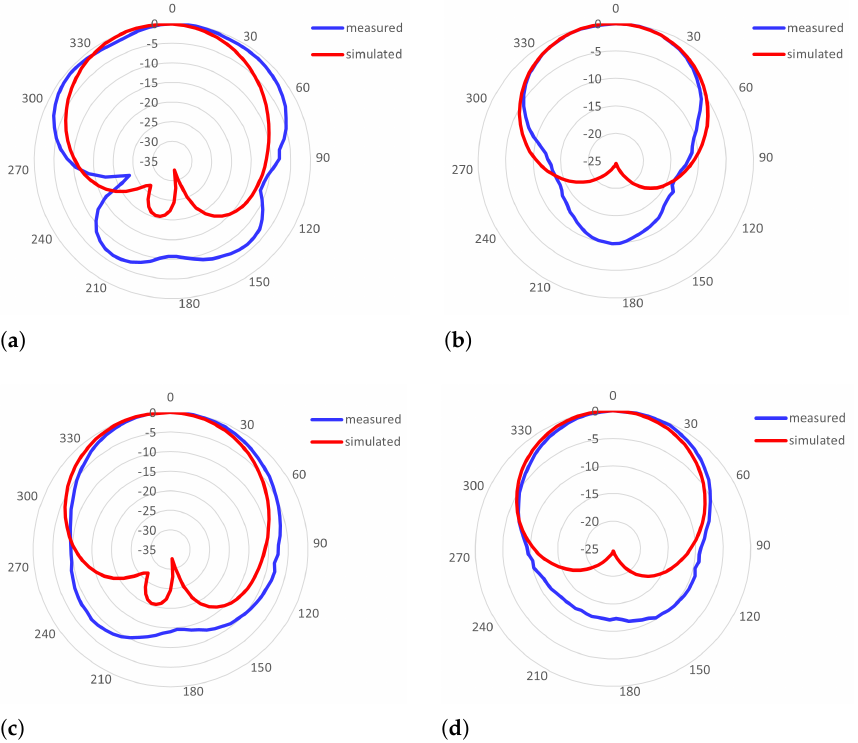
Figure 4. The simulated vs. measured radiation patterns of the Pyralux-based IRMAs with: ( a ) an SMA connector: E − plane; ( b ) an SMA connector: H − plane; ( c ) a U.FL connector: E − plane; and ( d ) a U.FL connector: H − plane.